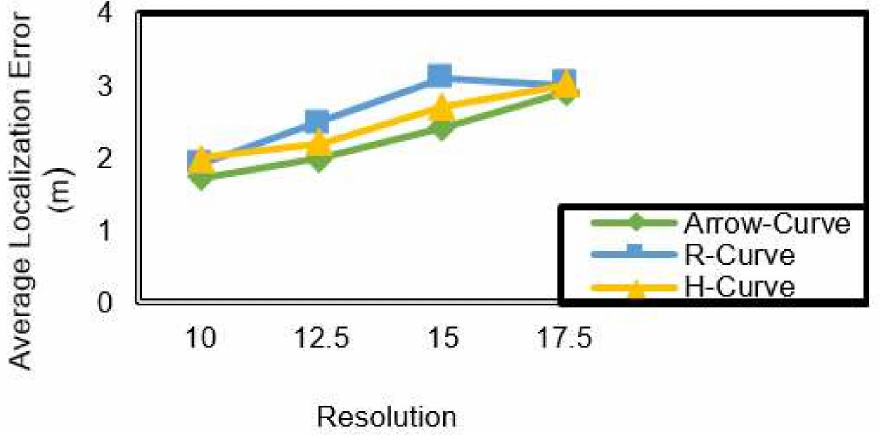
Figure 11. Average localization error (m) corresponding to resolution (L) in Arrow-Curve model, R-Curve model, and